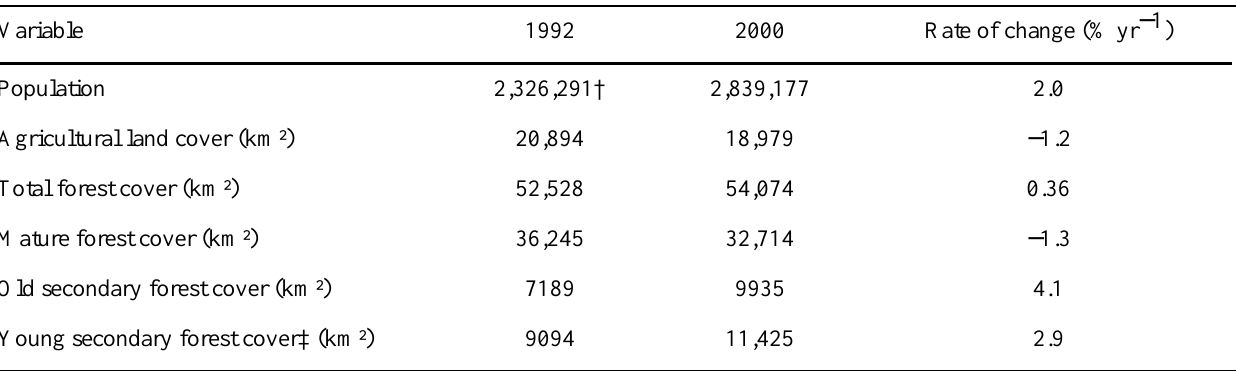
Table 1. Net change in the population between 1990 and 2000 and net change in forest cover between 1992 and 2000 for the Republic of